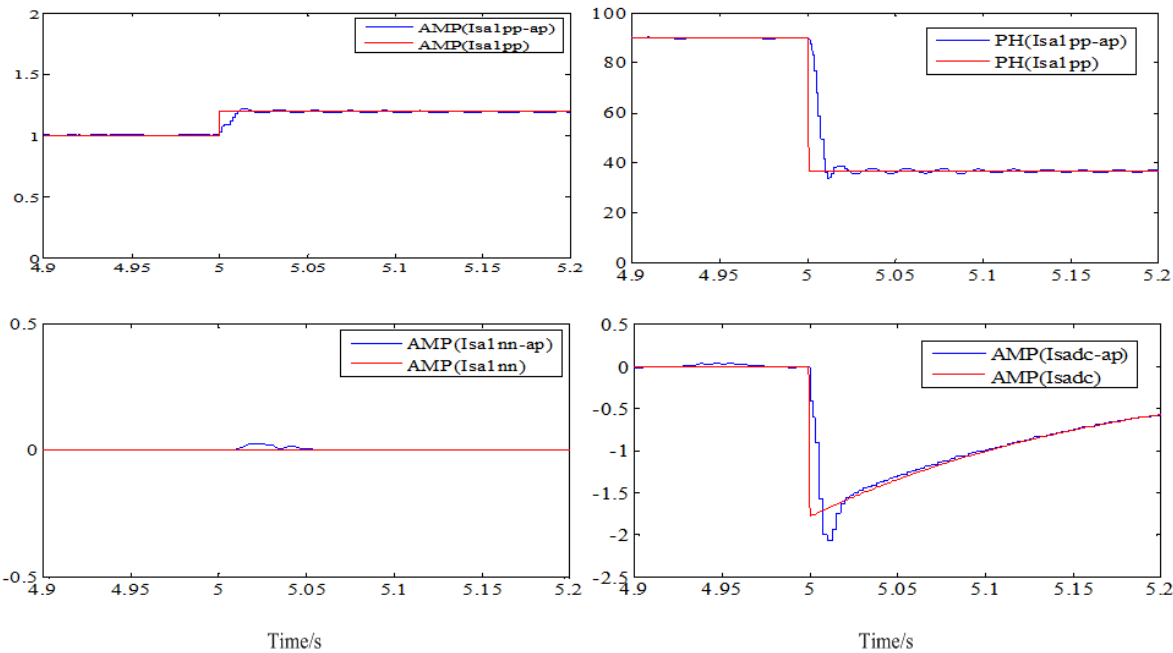
Figure 9. The A phase current under condition of a Phase-C ground